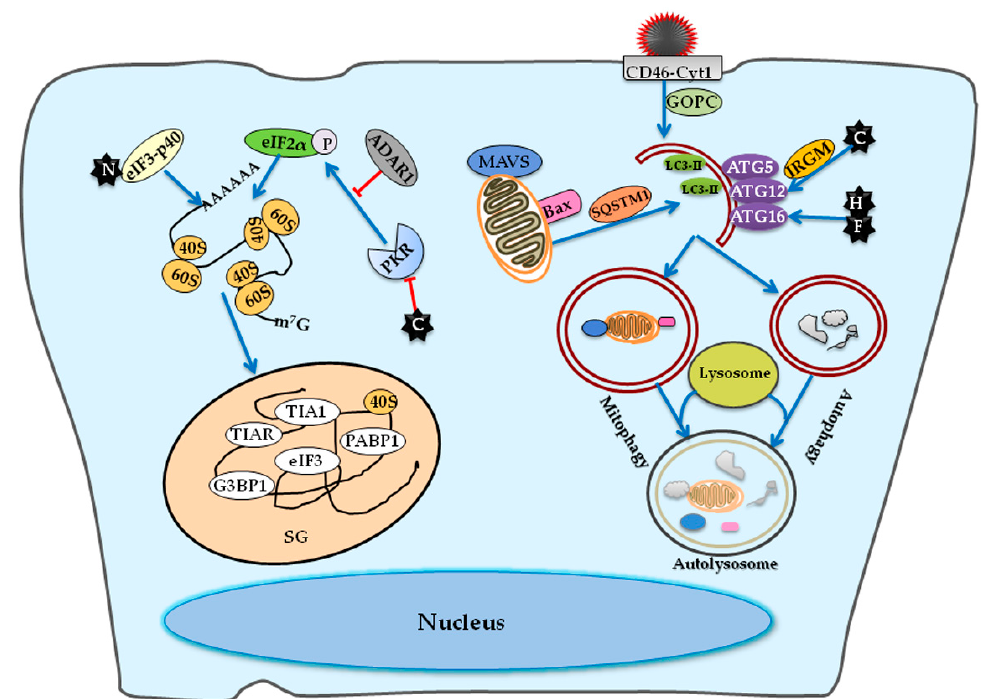
Figure 3. A diagram of host factors involved in MeV inducible stress granule formation and autophagy. The C protein suppresses the activation of PKR, so a mutant MeV lacking C protein expression rather than the wild-type MeV induces the stress granule (SG) formation. The N protein binds to the eIF3-p40 and then promotes SG formation. As a suppresser of PKR, ADAR1 suppresses the PKR-dependent SG formation. The infection of Edmonston-MeV strain initiates an early but transient autophagy wave via the engagement of CD46-Cyt-1 in a Golgi-associated PDZ and coiled-coil motif-containing protein (GOPC)-dependent pathway. Moreover, the expression of C protein can induce an autophagic signaling in an immunity-related GTPase M (IRGM)-dependent manner. The expression of H and F proteins in cells expressing one of the cellular receptors is also sufficient to induce autophagy. The Edmonston-MeV strain also exploits the selective mitophagy via recognition of damaged mitochondria by autophagic receptor SQSTM1, resulting in the degradation of mitochondrion-tethered mitochondrial antiviral-signaling protein (MAVS) and subsequent attenuation of RIG-I/MDA5-mediated responses. The arrows indicate the activation of innate immune responses while the T-ended arrows indicate the repression by MeV.